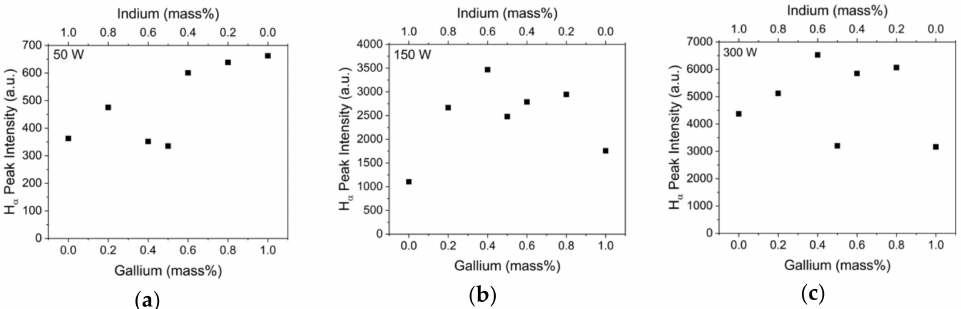
Figure 2. H α Peak Intensity (a.u.) vs. Alloy Composition (mass%) for various powers ( a ) 50 W, ( b ) 150 W and ( c ) 300